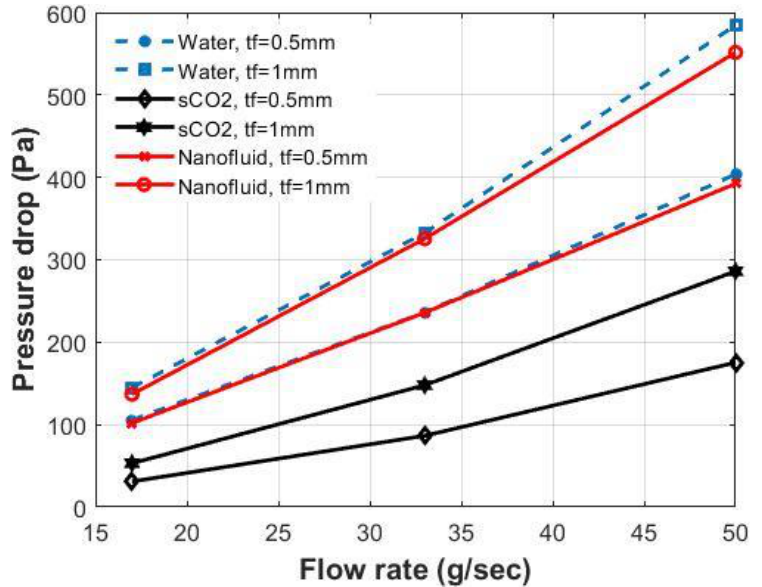
Figure 7. Pressure drop at different flowrates corresponding to different coolants and fin thick- nesses.